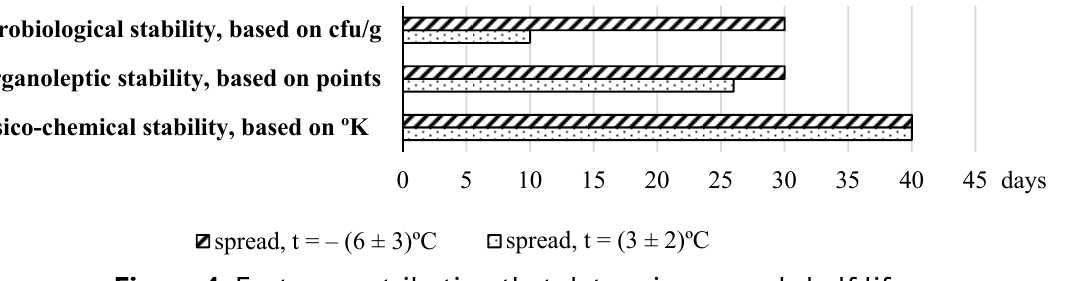
Figure 4. Factors contribution that determine spread shelf